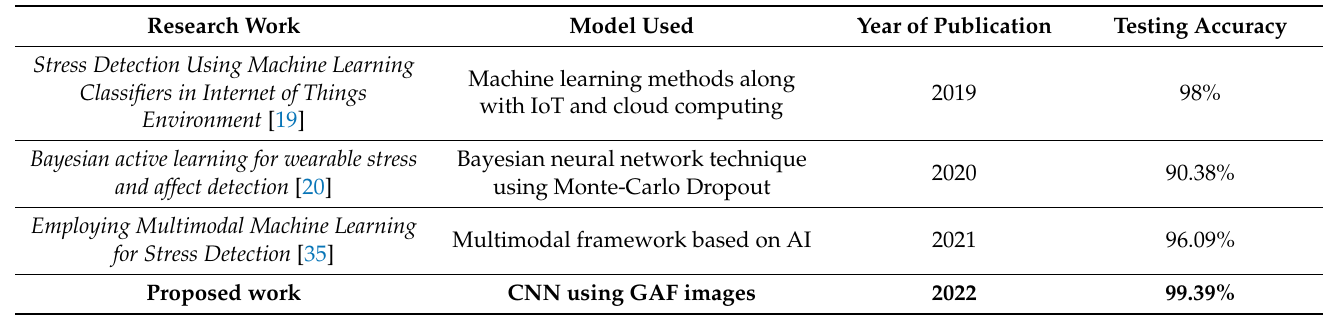
Table 6. Comparison of our proposed image encoding-based deep neural network model with previously proposed works related to SWELL